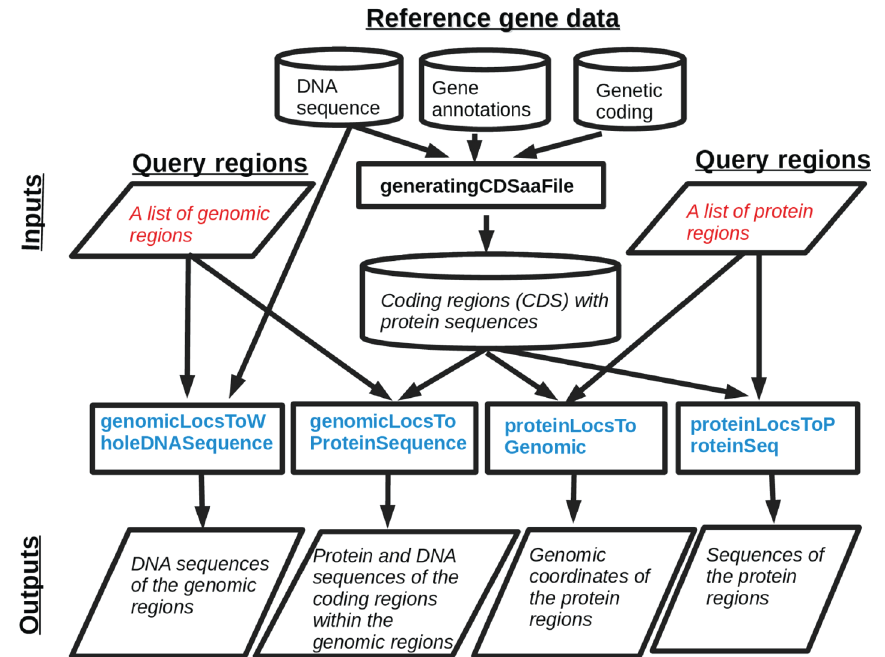
Figure 1: A workflow depiction of all the functions and their inputs, outputs and relations in the R package geno2proteo. 1. genomicLocsToProteinSequence takes a list of genomic regions as the input and finds the amino acid sequences and the DNA sequences of the coding regions within those genomic